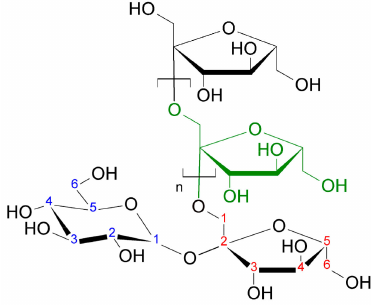
Figure 1. The general structural formula of